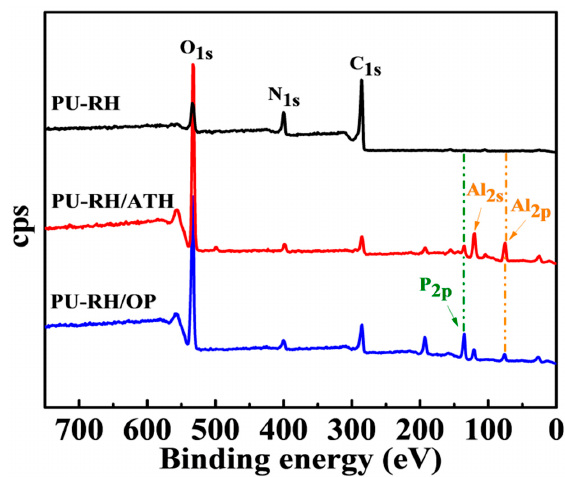
Figure 8. XPS of the PU–RH, PU–RH/ATH, and PU–RH/OP residual chars after the cone calorimetry. Polymers 2019 , 11 , x FOR PEER REVIEW